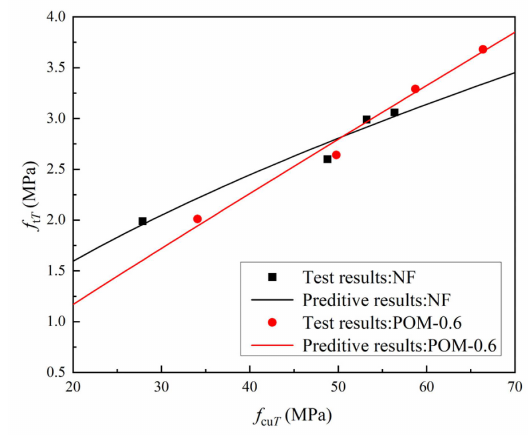
Figure 15. Relations between f tT / f t28 and concrete age.